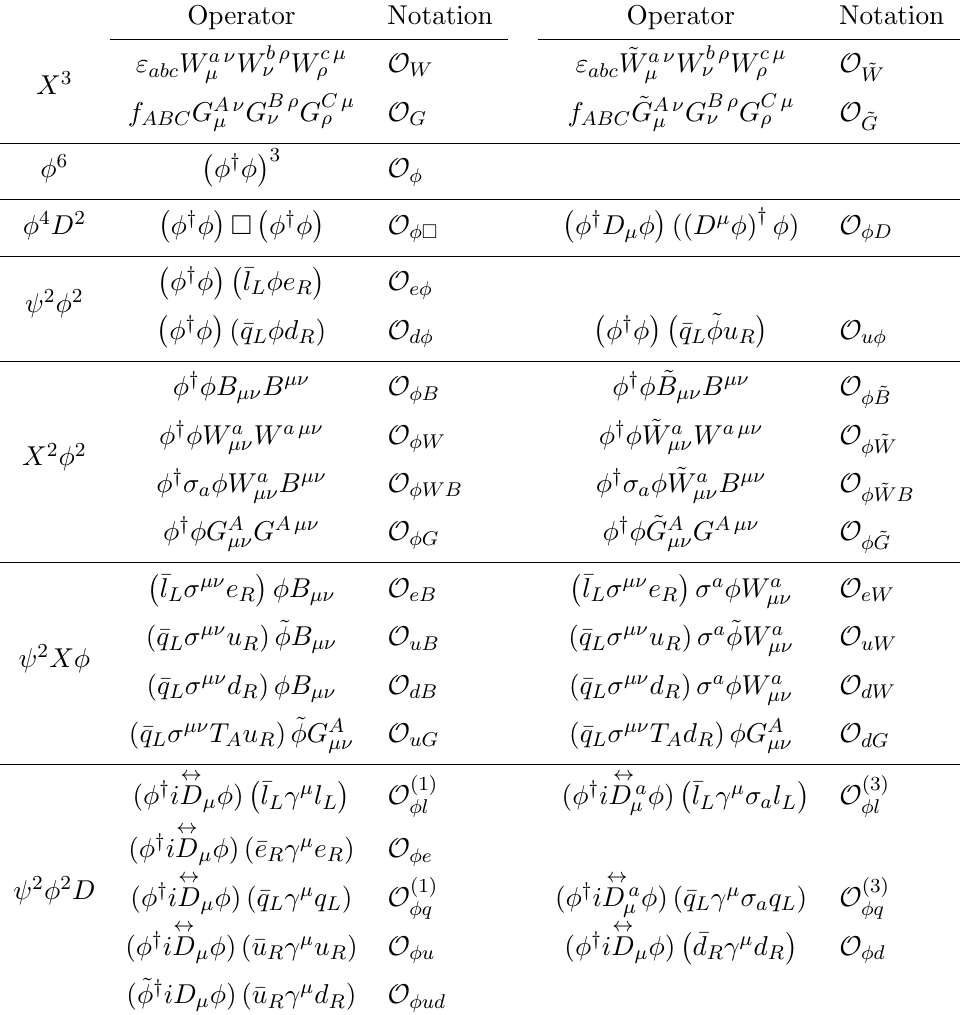
Table 6 . Basis of dimension-six operators: operators other than four-fermion interactions. Flavor indices are